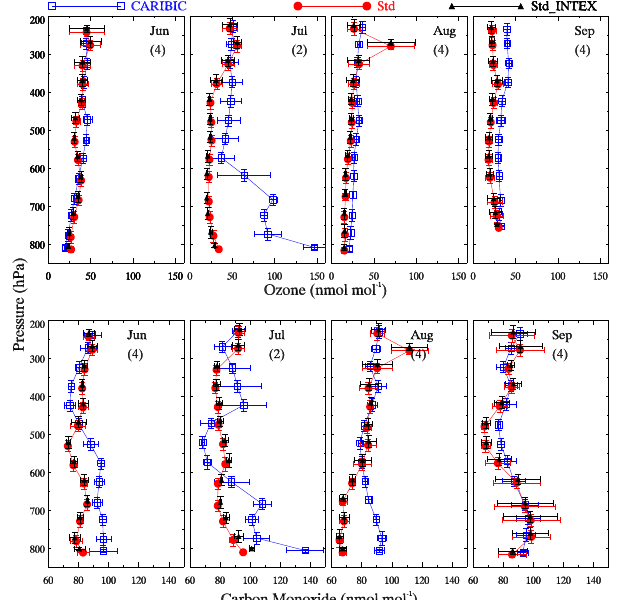
Figure 3. Comparison of monthly average ozone and carbon monoxide profiles from standard WRF-Chem simulations (Std) with the CARIBIC observations during June, July, August and September 2008. Numbers in brackets denote the number of ob- servational profiles in the respective month. Model output has been spatially and temporally interpolated along the CARIBIC flight tracks. Comparison with another simulation Std_INTEX is indi- cated in black.